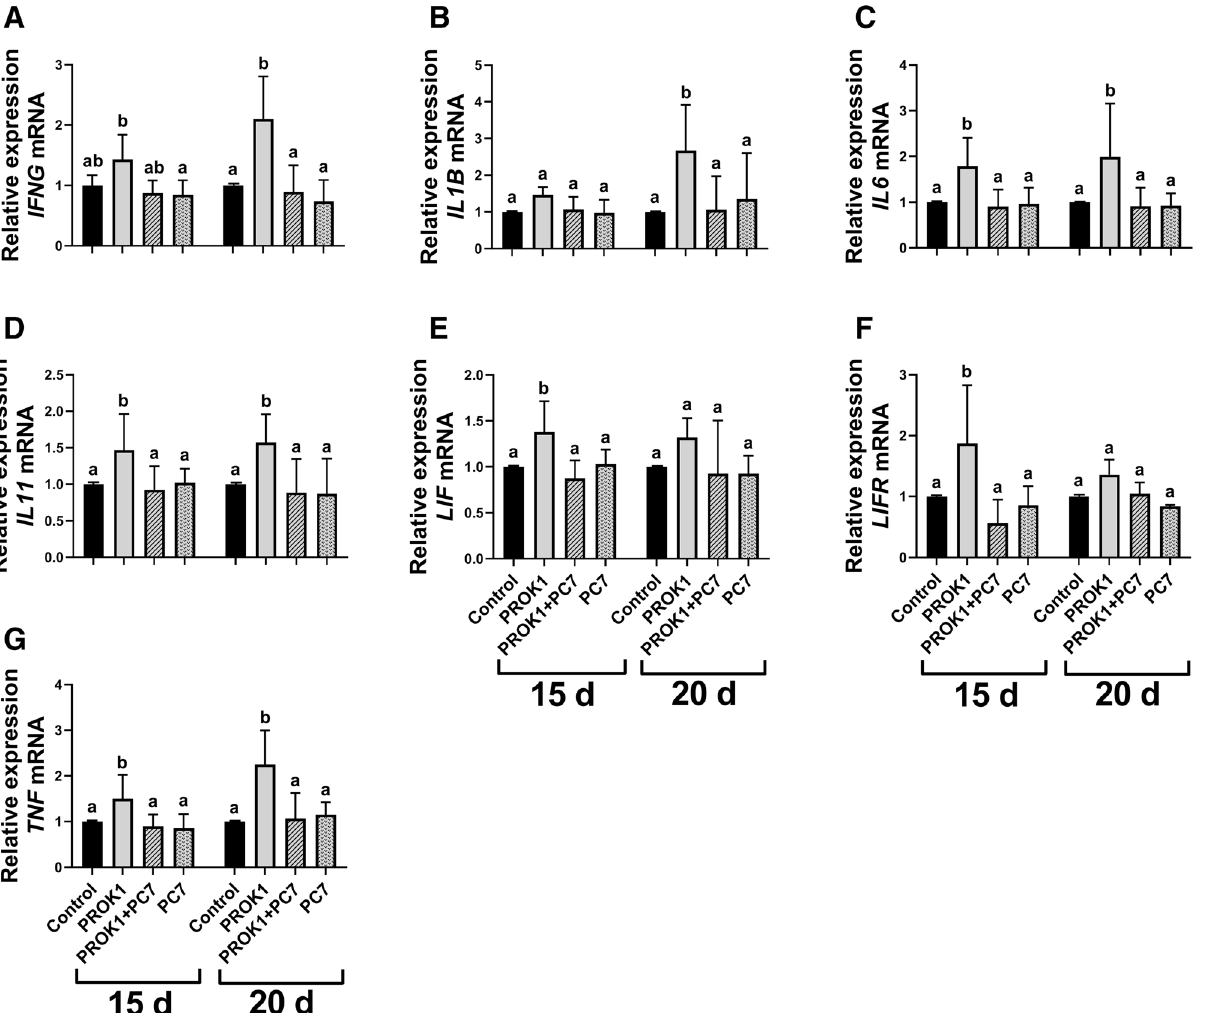
the immunological response in the porcine trophoblast on days 15 and 20 of pregnancy in vitro: ( A ) interferon gamma ( IFNG ); ( B ) interleukin 1 beta ( IL1B ); ( C ) interleukin 6 ( IL6 ); ( D ) interleukin 11 ( IL11 ); ( E ) LIF interleukin 6 family cytokine ( LIF ); ( F ) LIF receptor subunit alpha ( LIFR ), and ( G ) tumor necrosis factor ( TNF ). Primary trophoblast cells were incubated with the control (vehicle) or PROK1 (40 nM) for 24 h in the presence/ absence of a PROKR1 antagonist (PC7; 1 µM). Data are presented as the mean ± SEM of the fold change versus control. Different letters (a–b) indicate statistically significant differences ( P < 0.05). Means sharing at least one the same letter indicate no significant